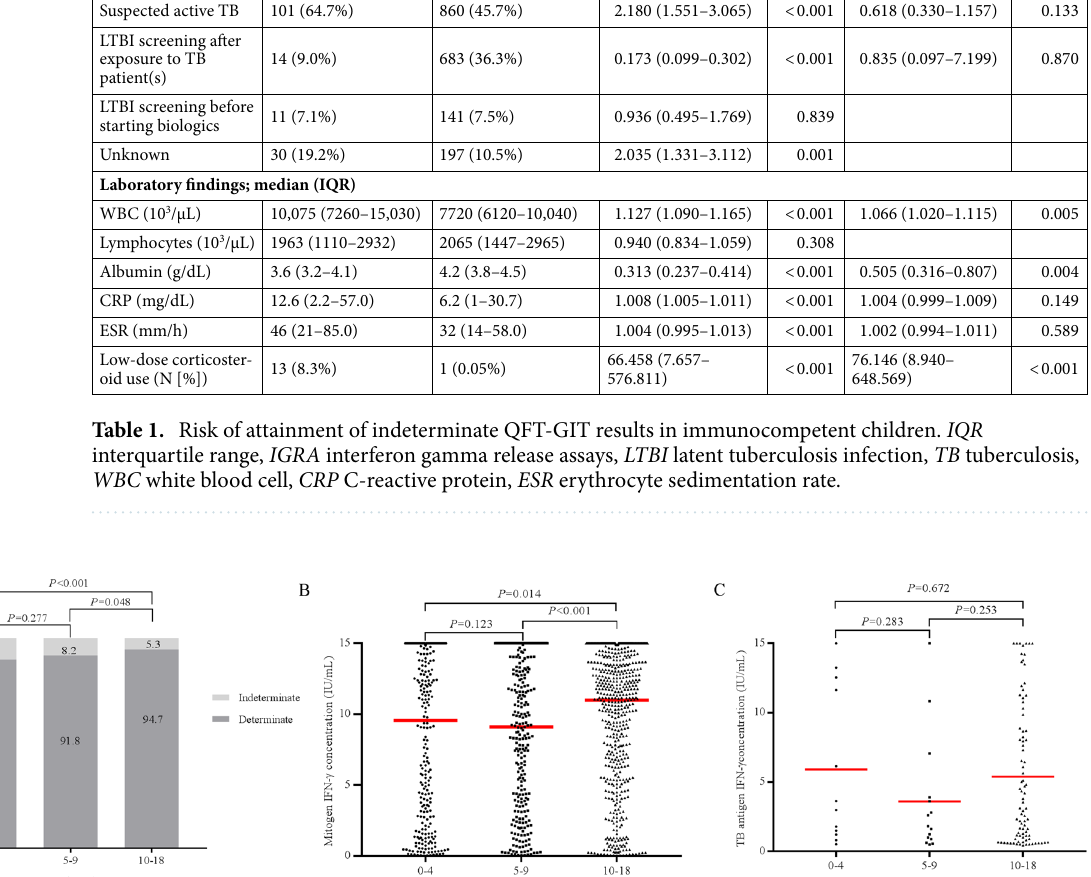
Figure 2C depicts the median IFN-γ response (censored at 15 IU/mL) to the TB antigen among children with a positive QFT-GIT result. The median response to the TB antigen did not differ significantly among the three groups.